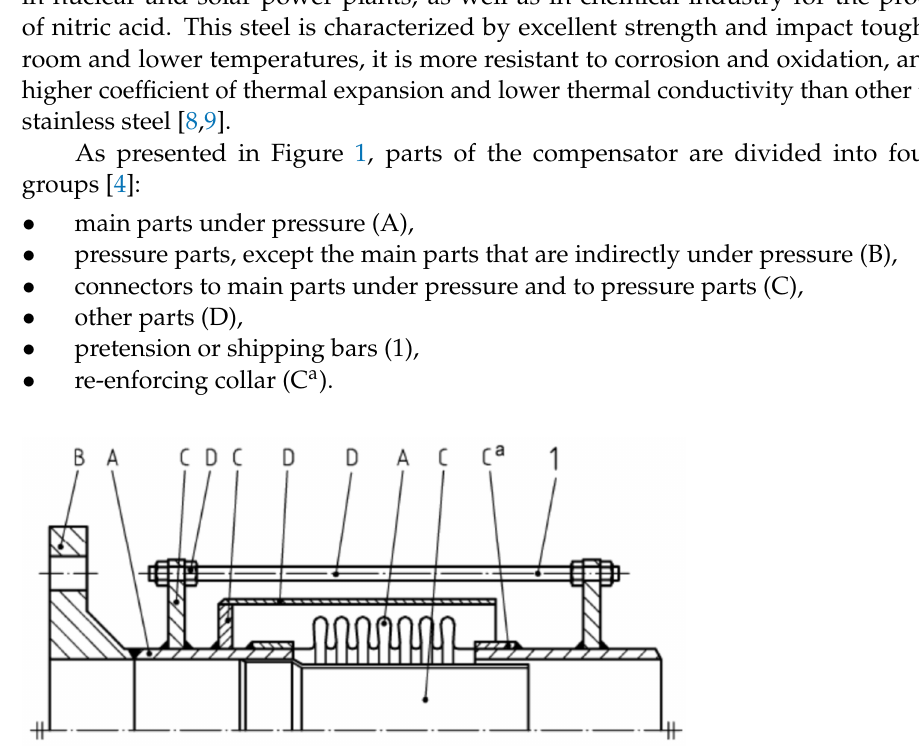
Figure 1. Axial compensator with internal pressure and categorization of material